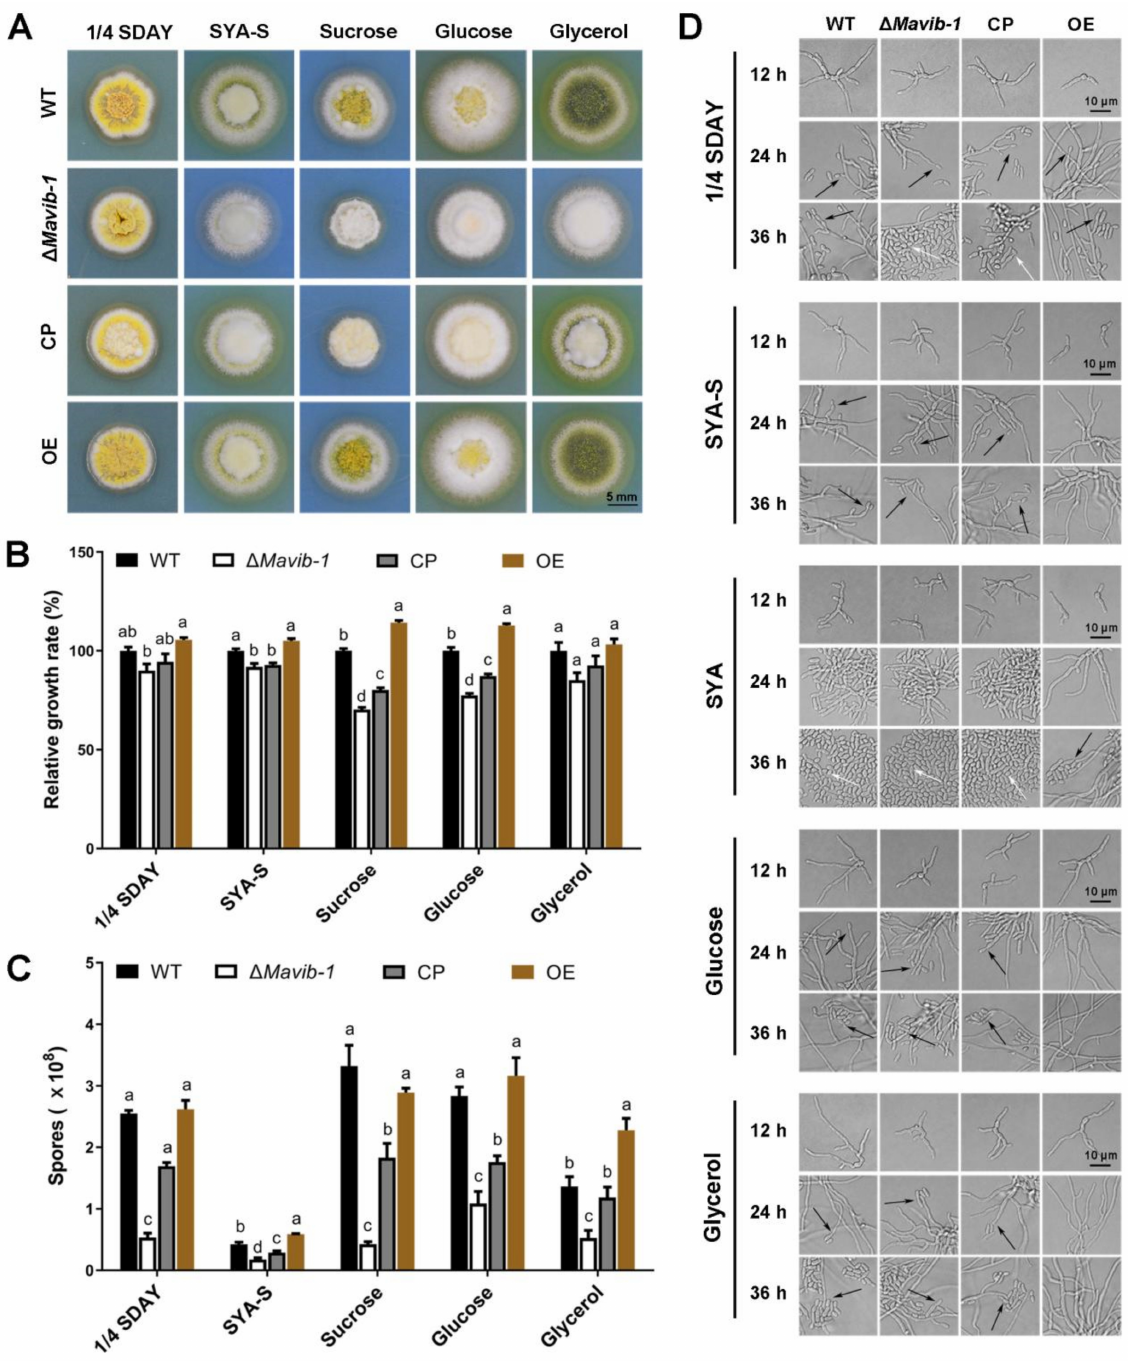
Figure 4. Colony growth and conidiation of fungal strains on media containing different carbon sources. ( A ) Colony morphology of WT, ∆ Mavib-1 , CP and OE strains. Fungal strains were cultured on the nutrient-rich medium 1/4 SDAY, and nutrient-limited medium SYA with easy-to-use or difficult- to-use carbon sources (3% w/v ; easy to use: glucose; middle: sucrose, difficult to use: glycerol) for 5 d. Colony relative growth rate ( B ) and conidial yield ( C ) of WT, ∆ Mavib-1 , CP and OE strains cultured on 1/4 SDAY or SYA with different carbon sources for 5 d. The trial was repeated three times. Error bars are standard deviations of three replicates. Different lower-case letters indicate significant difference at p < 0.05. ( D ) Conidiation of WT, ∆ Mavib-1 , CP and OE strains on different media. The black arrows indicate normal conidiation, and the white arrows indicate microcycle